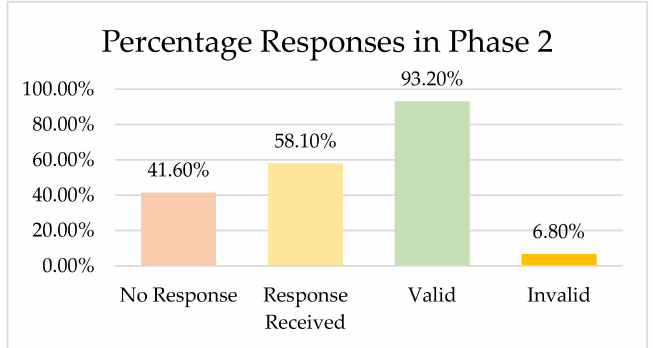
Figure 5. Percentage of total questionnaires sent and their turnover.